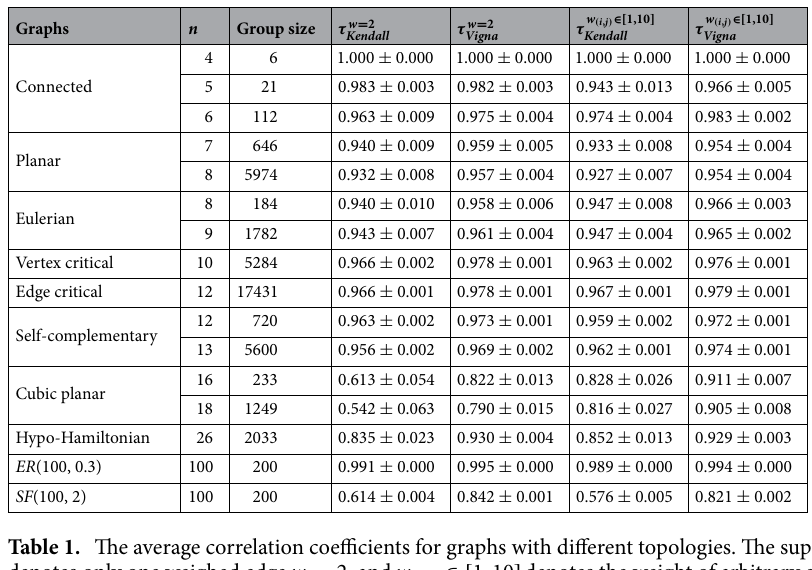
2 , and w ( i , j ) 1, 10 denotes the weight of arbitrary edge in [1, 10]. = ∈ [ ]